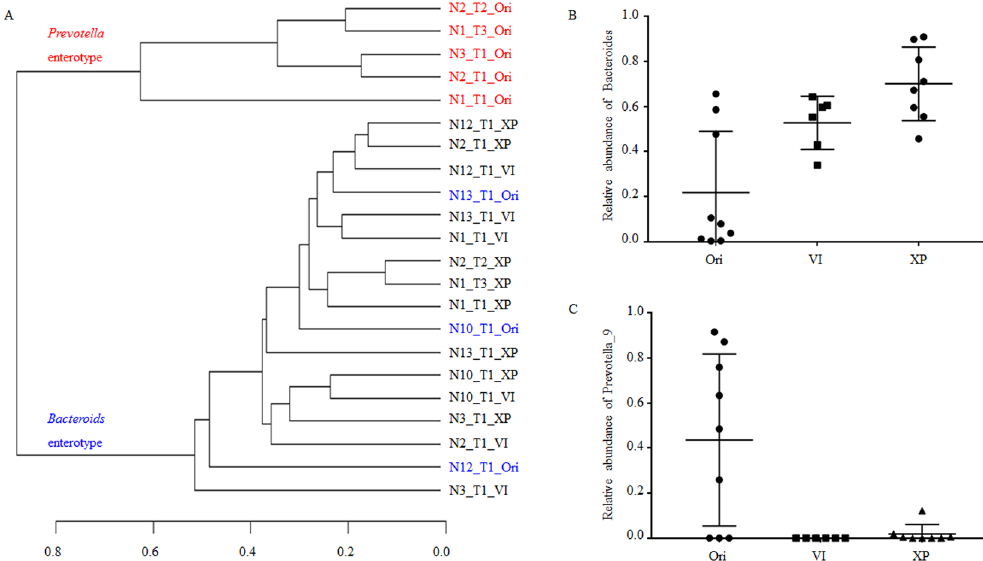
Figure 3. Chemostat simulation of cultures of Bacteroides and Prevotella enterotypes. Culture media VI, XP, MD1, and MD2 were used to simulate the bacterial communities of Bacteroides and Prevotella enterotypes in vitro . ( A ) Cluster analysis of the relationship among fecal samples and chemostat cultured samples according to the percentage of each genus. ( B ) The percentage of genera Bacteroides and Prevotella in fecal and chemostat cultured samples.